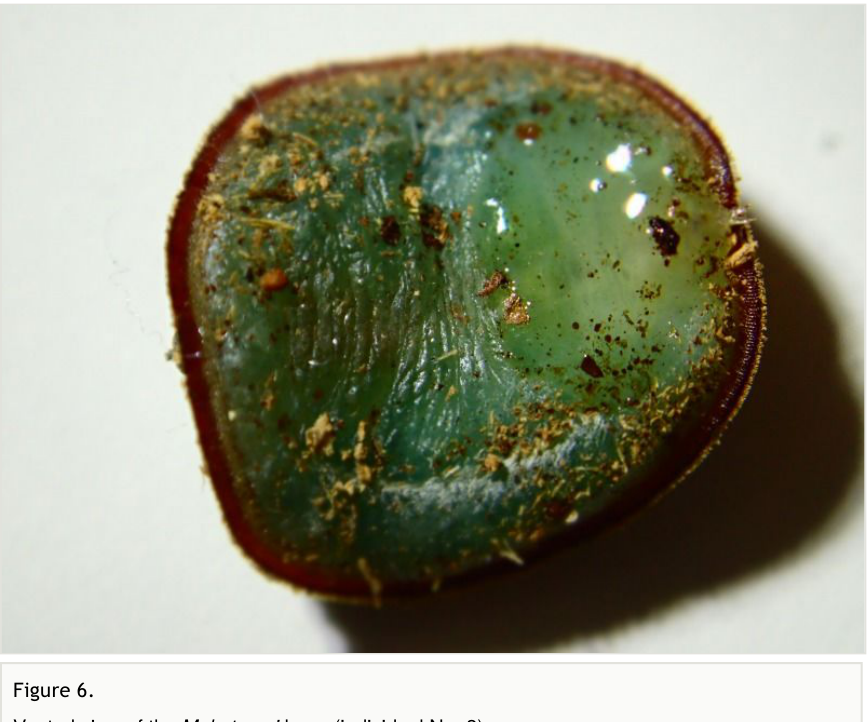
Figure 6. Ventral view of the M. katsurai larva (individual No.